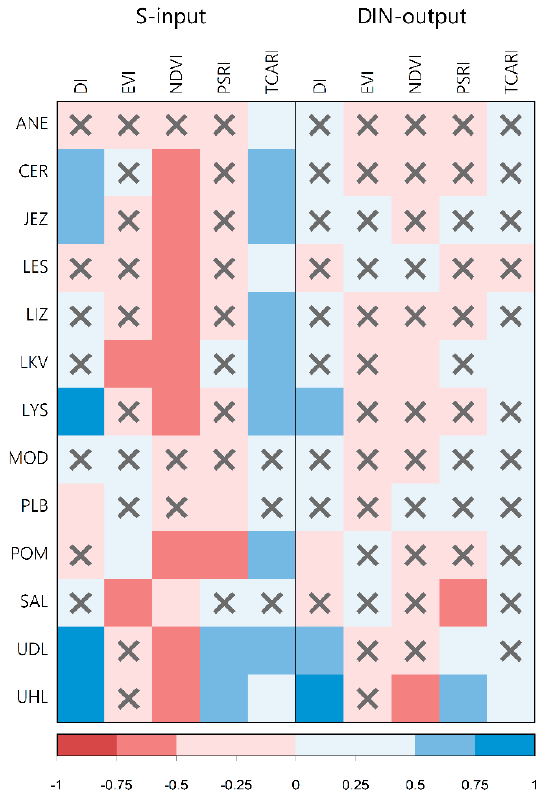
Figure 4. Pearson correlation coefficients computed between measured sulfur deposition (S-input) or stream water dissolved inorganic nitrogen export (DIN-output) and selected vegetation indices from the Landsat satellite data. Crosses indicate non-significant correlations ( p > 0.05).